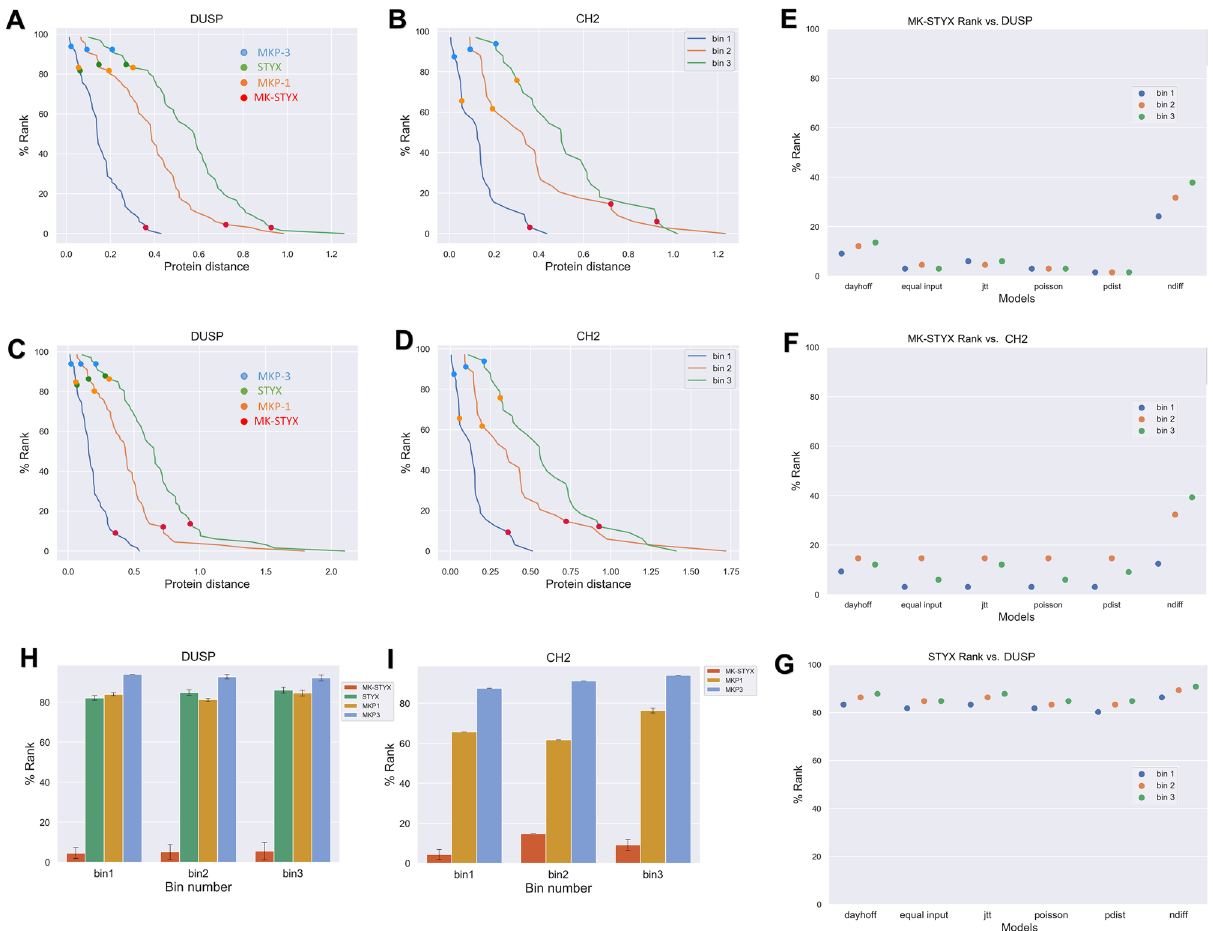
Figure 2. Ranks of the mean distances of MK-STYX, STYX, MKP-1, and MKP-3 by different models. ( A ) Cumulative probability histogram representing the mean distance of proteins with the DUSP domain as calculated by the equal input model in the first three bins. The rank of MK-STYX is indicated by a red circle, the rank of MKP-3 is indicated by a blue circle, the rank of STYX is indicated by a green circle, and the rank of MKP-1 is indicated by an orange circle. ( B ) Cumulative probability histogram (as in A ) of proteins with the CH2 domain. The rank of MK-STYX is indicated by a red circle, the rank of MKP-3 is indicated by a blue circle, and the rank of MKP-1 is indicated by an orange circle. ( C ) Cumulative probability histogram representing the mean distance of proteins with the DUSP domain as calculated by the Dayhoff model in the first three bins. The rank of MK-STYX is indicated by a red circle, the rank of MKP-3 is indicated by a blue circle, the rank of STYX is indicated by a green circle, and the rank of MKP-1 is indicated by an orange circle. ( D ) Cumulative probability histogram (as in C ) of proteins with the CH2 domain. The rank of MK-STYX is indicated by a red circle, the rank of MKP-3 is indicated by a blue circle, and the rank of MKP-1 is indicated by an orange circle. ( E ) Dot plot showing the percentile rank of MK-STYX in the DUSP group by six different models. Ranks in the first three bins are shown. ( F ) Dot plot (as in E ) of MK-STYX in the CH2 group. ( G ) Dot plot showing the percentile rank of STYX in the DUSP group by six different models. Ranks in the first three bins are shown. ( H ) Bar chart showing the mean percentile rank of the distances of MK-STYX, STYX, MKP-1, and MKP-3 calculated by different models in the first three bins. Error bars are the standard deviations of bins. ( I ) Bar chart (as in F ) of MK-STYX, MKP-1, and MKP-3. Python (Core Team 2015; https:// www. python. org.) packages Matplotlib (version2.2.2; https:// doi. org/ 10. 5281/ zenodo. 12020 77) and Seaborn 57 were used to plot and analyze data. The layout was designed in Microsoft